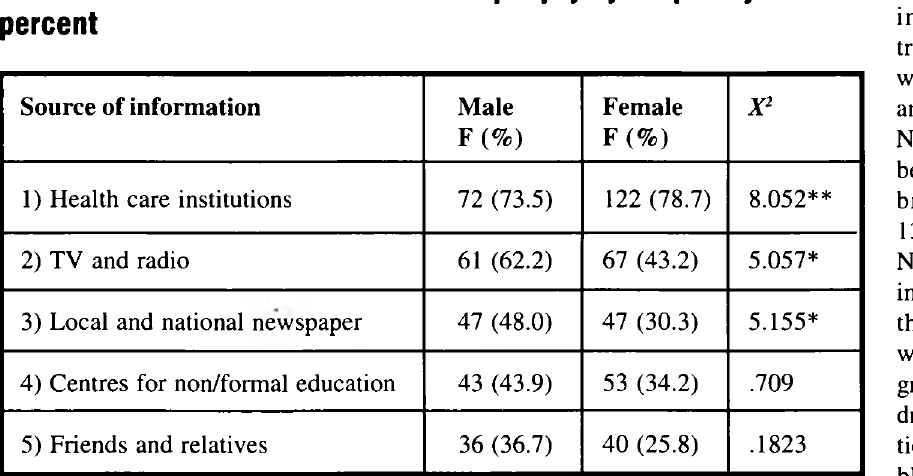
Table 5: Source of information about epilepsy by frequency and in percent